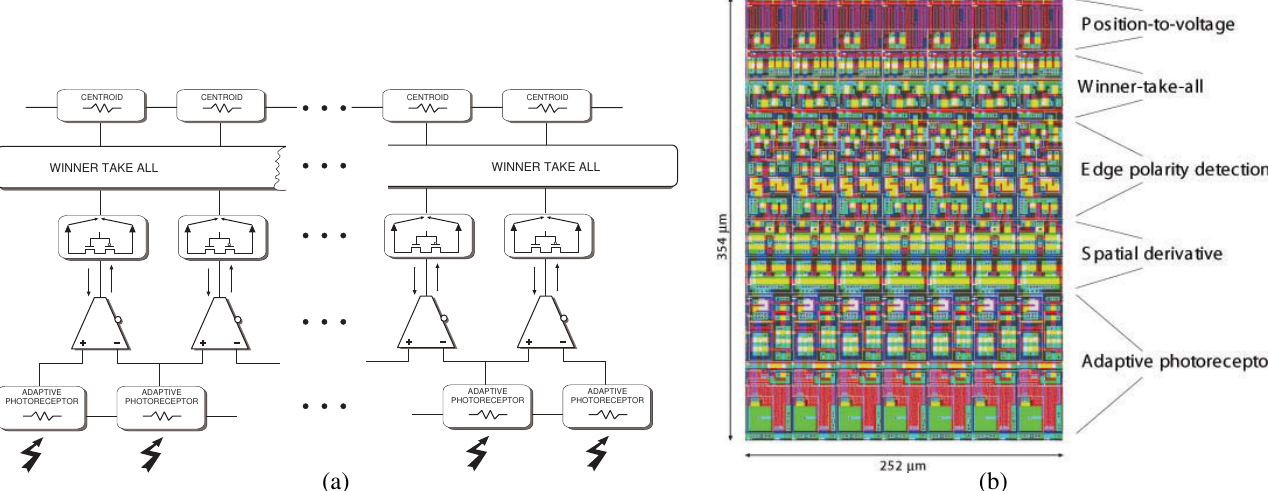
Figure 2 . (a) Block diagram of single-chip tracking system. Spatial edges are detected at the first computational stages by adaptive photo-receptors connected to transconductance amplifiers. The edge with strongest contrast is selected by a winner-take-all network and its position is encoded with a single continuous analog voltage by a position-to-voltage circuit. (b) Portion of the chip layout containing 7 processing